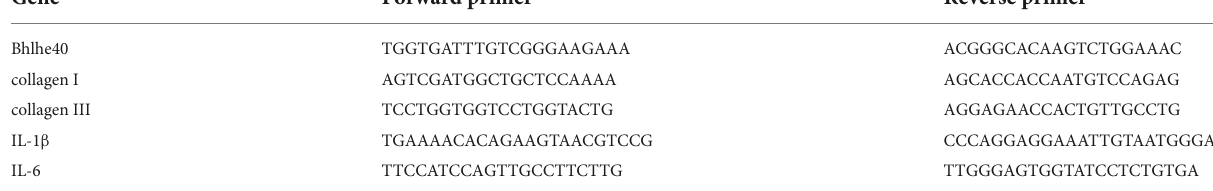
TABLE 1 Primers used in